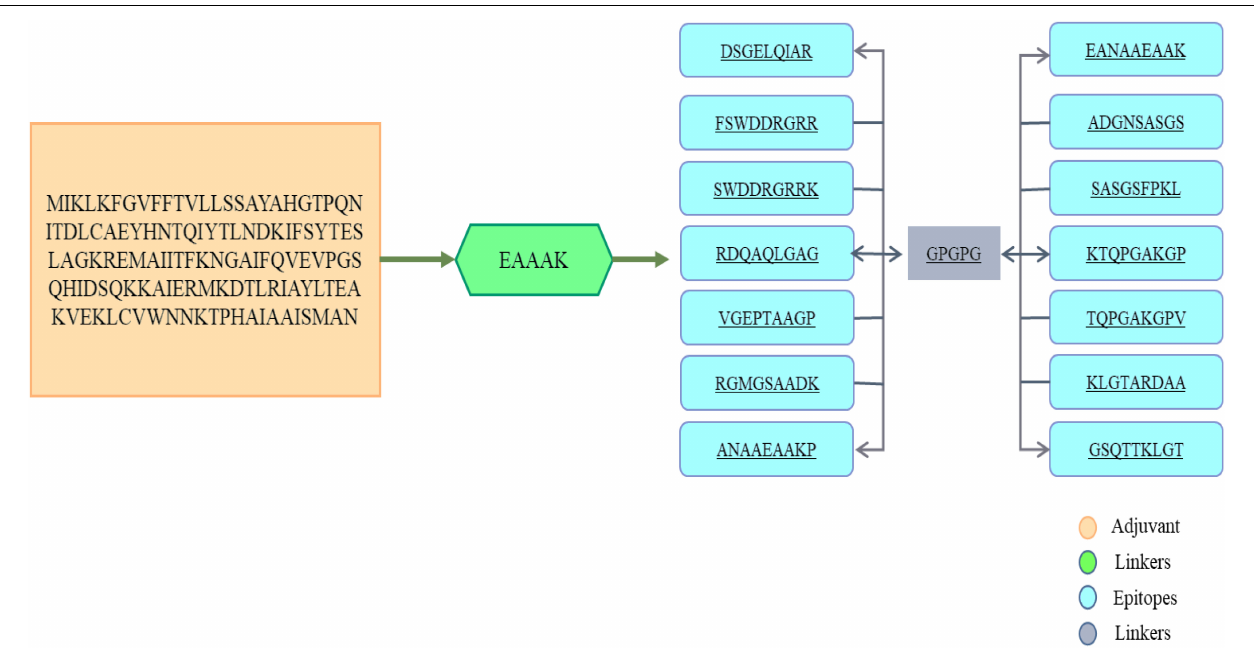
FIGURE 4 | The primary amino acids sequence of vaccine. To link the antigenic B-cell derived T-cell epitopes, GPGPG linkers were used as shown in gray block. At the amino terminal of the multi-epitope’s peptide, an adjuvant (cholera toxin B subunit) was attached shown in orange box while the EAAAK linker is shown in green color box.